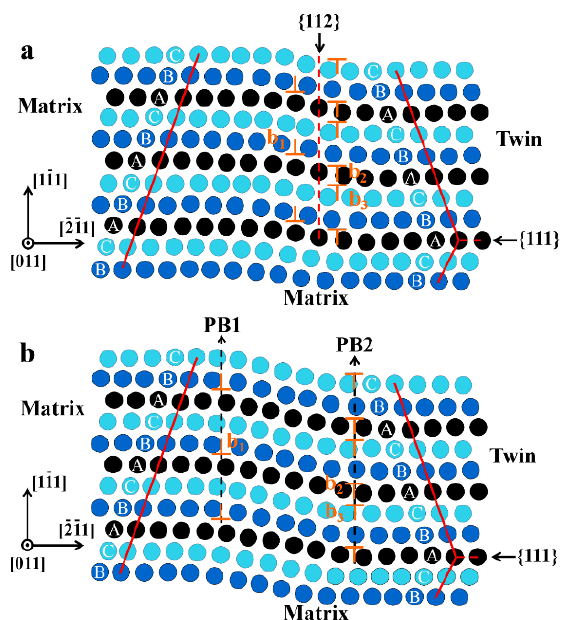
Figure 3. The schematic of the formation process of 9R. ( a ) The structure of the twin that is formed by the cooperative glide of three repeated partial dislocations; ( b ) The structure of 9R that is formed by the dissociation of twins.